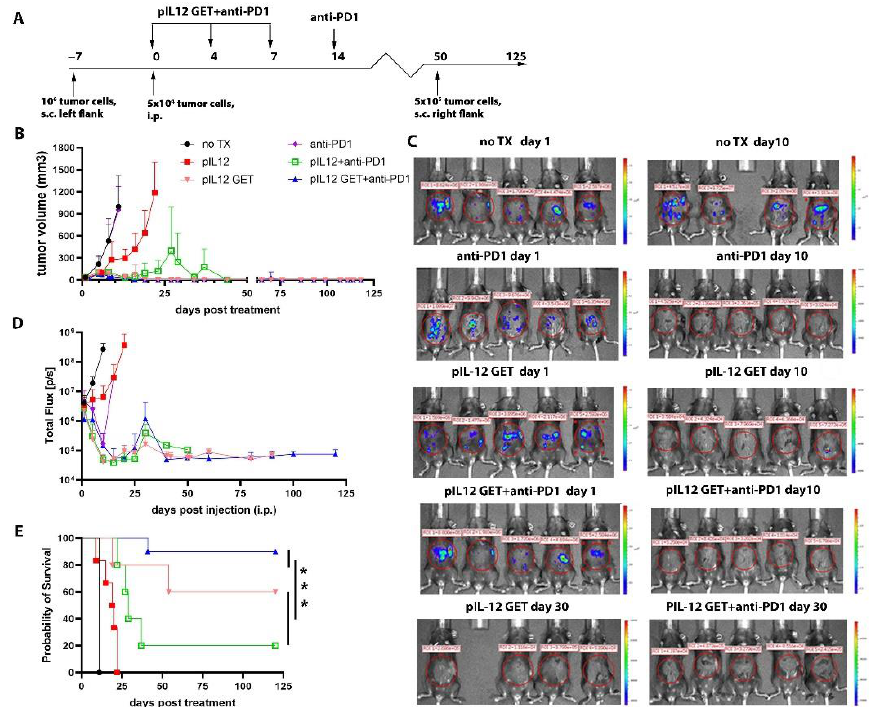
Figure 1. pIL-12 GET in combination with PD1 blockade produces potent rejection of established B16F10 melanoma in a two-tumor model. ( A ) The timeline of combination therapy. ( B ) Data are presented as tumor (s.c.) growth in each group (n = 5/group). ( C ) Representative images of tumors in mice (i.p.) are from in vivo imaging system. ( D ) Quantification of luciferase signal and tumor growth. ( E ) Cumulative survival for each group. ***, p < 0.001.